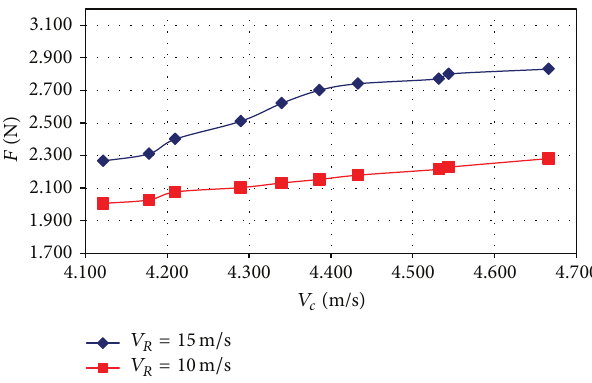
Figure 8: A comparative analysis of the variation of the lateral force for a constant 𝑉 𝑅 of 15m/s and 10m/s,